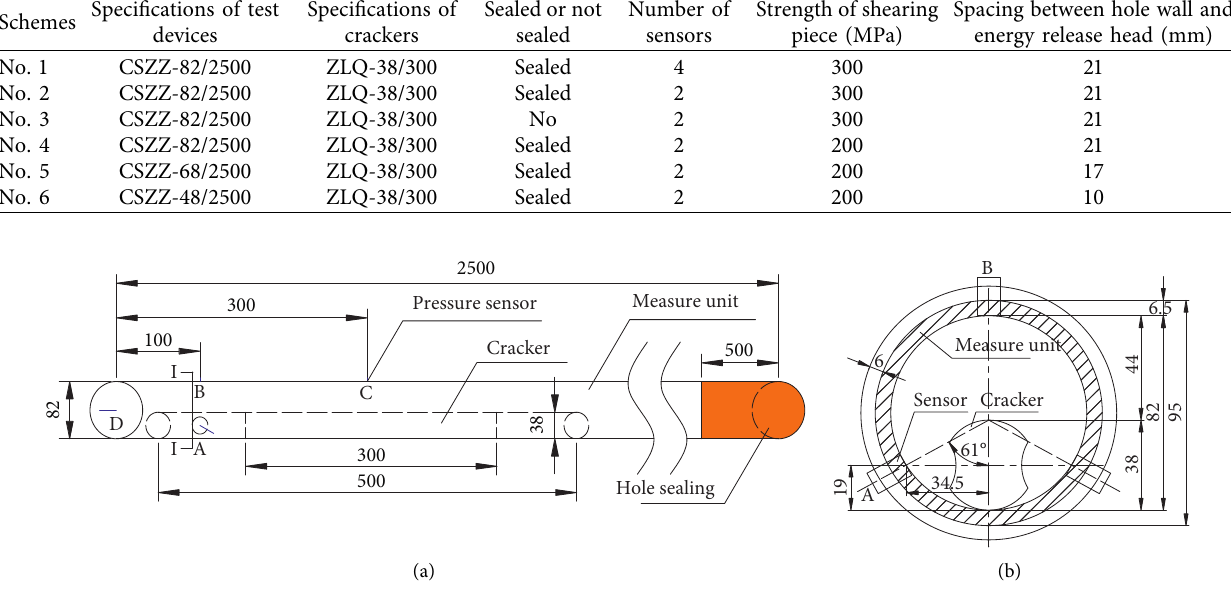
Figure 6: Diagram of force tests at different positions (length unit: mm).